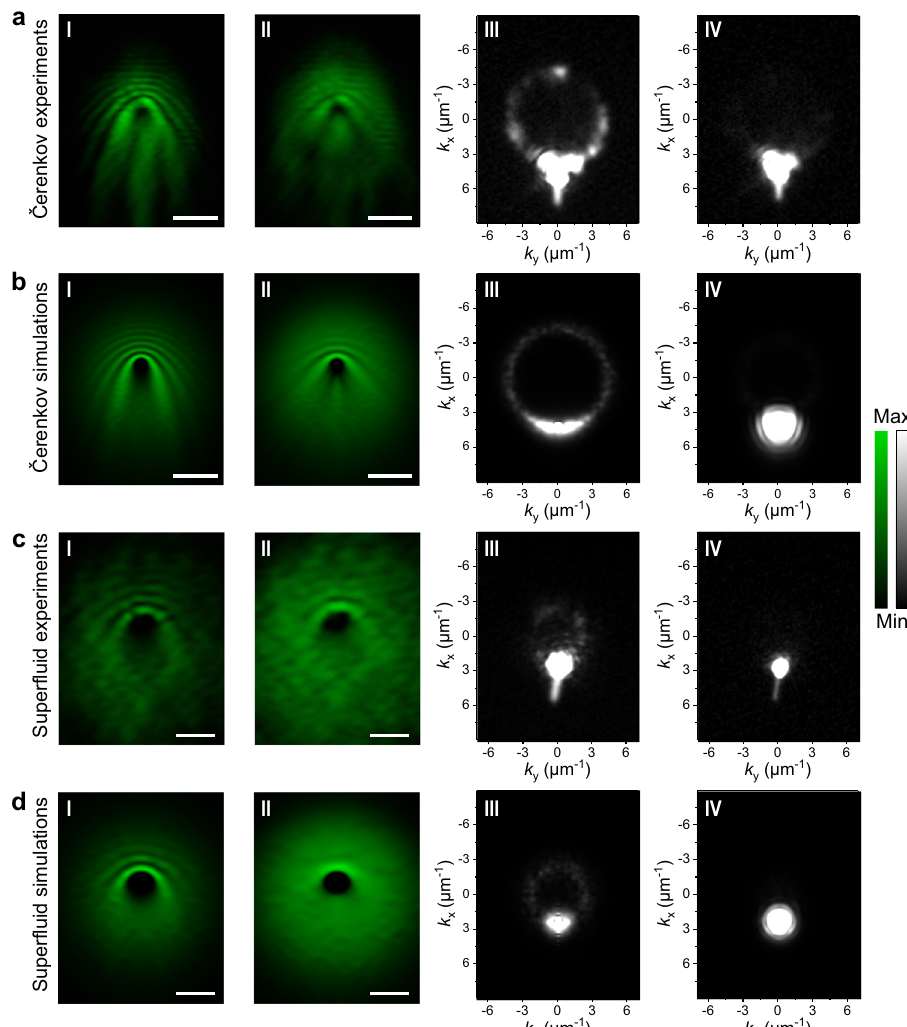
Fig. 4 | Demonstration of two-dimensional full polariton hydrodynamic tran- sitions from a normal fl uid to both a Č erenkov supersonic and a super fl uid fl uid. a -I, a -II Experimental real-space images of polariton fl owing with injection momentum of k || = 4.2 μ m − 1 across a defect with resonance pumping power in the cavityof0.07(I)and6(II) μ Jcm − 2 ,respectively. a -III-IV,Theexperimentalsaturated images of momentum distributions corresponding to a -I and a -II, respectively. At low polariton density ( a -I, a -III), the scattering by the defect generated parabolic interference wavefronts and Rayleigh scattering ring. When polariton density increased, Č erenkov behavior in the supersonic regime (c s <v p ) was shown as the linear wavefronts and the increased aperture angle. The scattering ring gets modi fi ed at high polariton density ( a -IV). b -I, b -II, the time-averaged simulation in real-space before and after the transition, respectively.Evenly distributed0-5meV exciton energy random variations are added to only 0.3% of the spatial pixels to better fi t the experimentalresults. b -III, b -IV The time-averaged simulationimages